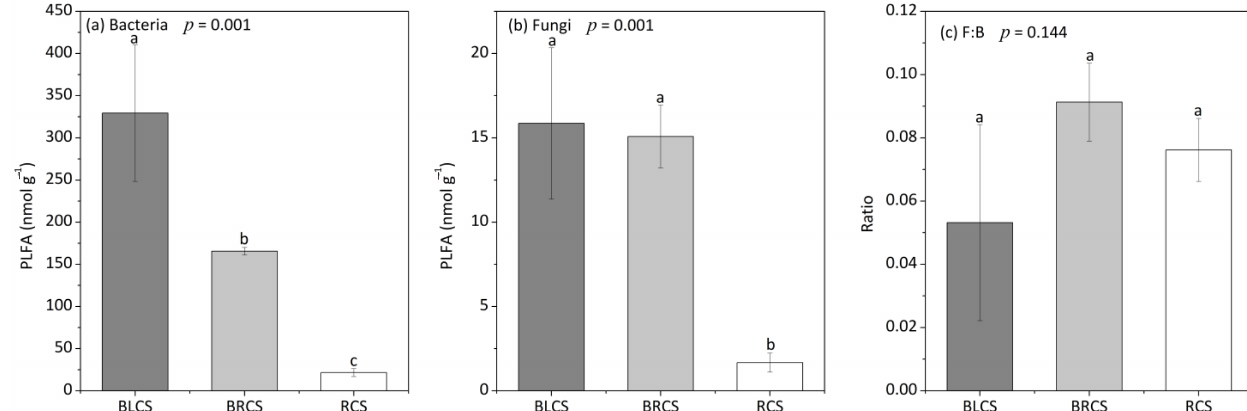
Figure 2. Effects of soil evolvement of calcareous soil on the concentrations of bacterial phospholipid fatty acid (PLFA) ( a ), fungal PLFA ( b ), and the fungi to bacteria ratio ( c ) in the subtropical karst area of southwest China. Values are means with standard error (SE), n = 3. Different lowercase letters denote significant difference at p < 0.05 level among different calcareous soils. BLCS, BRCS, and RCS represent black calcareous soil, brown calcareous soil, and red calcareous soil, respectively, the same